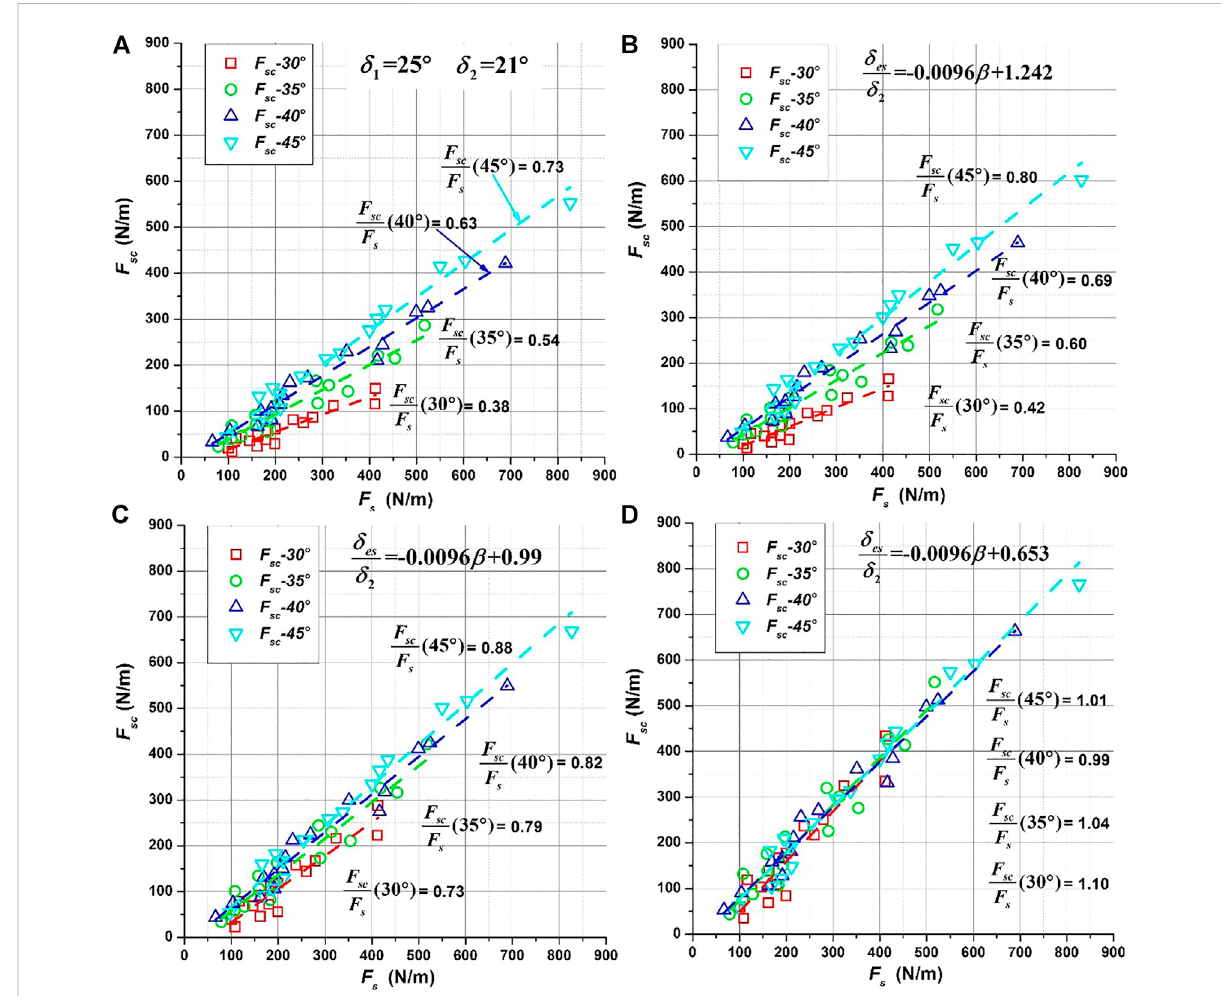
FIGURE 6 Comparison of calculated normal force of static phase ( F sc ) with normal force of experimental measurement ( F s